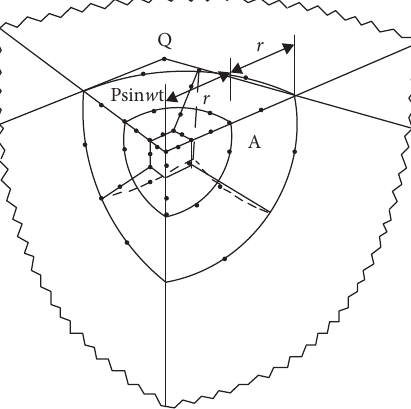
Figure 3: SBFEM discretization of 1/4 unbounded half-space.